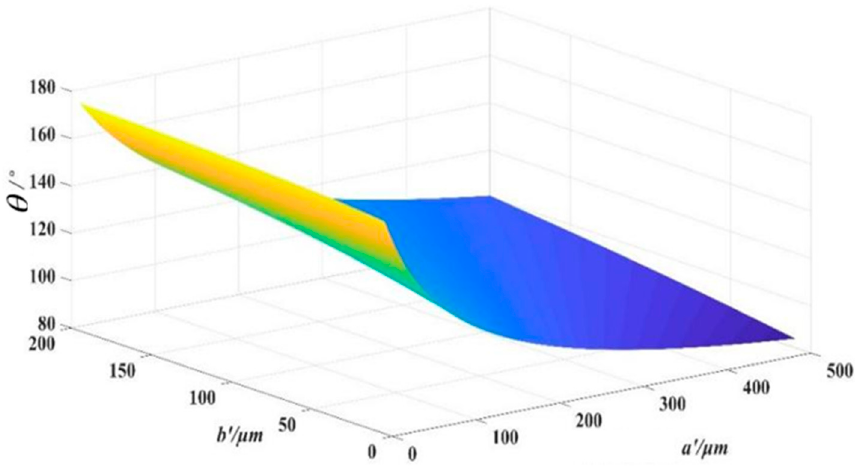
Figure 14. The 3D relation curve of contact angle and secondary microstructure parameter under the Cassie model.